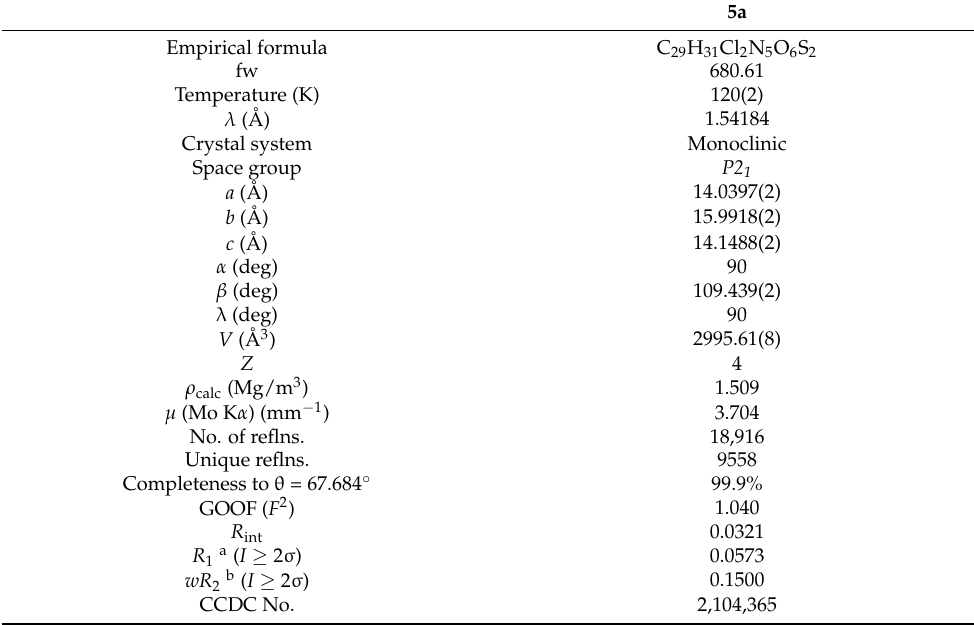
Figure 1. Atom numbering and thermal ellipsoids at 30% probability level for 5a . Only one unit (unit a) is presented; the second unit and the crystallized solvent molecules are not shown for simplicity. Table 1. Crystal data of compound 5a .